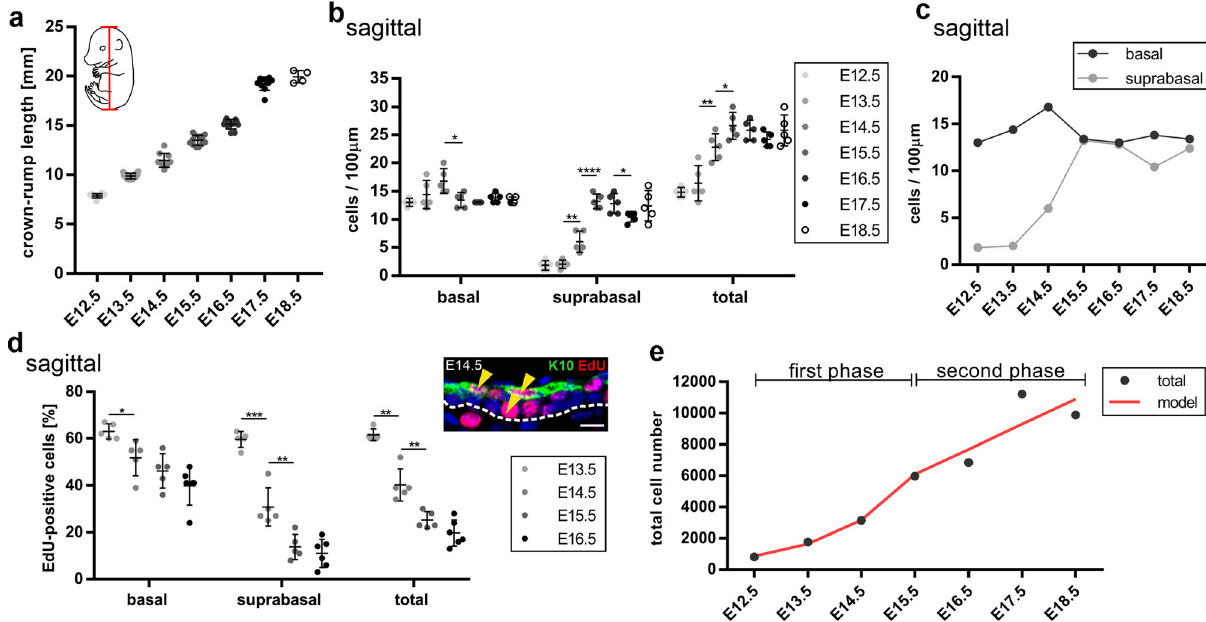
Fig. 6 Skin epidermal strati fi cation occurs in two phases. a Quanti fi cation of the crown-rump distance as depicted in the embryo schematic (red line) in wild-type embryos from E12.5 – E18.5. Note the linear trend of the growth. E12.5: n = 10, E13.5: n = 16, E14.5: n = 10, E15.5: n = 12, E16.5: n = 11, E17.5: n = 10 and E18.5: n = 4 b , c Cell densities (cells per 100 µ m) of basal and suprabasal layers of sagittal back-skin sections of the epidermis from E12.5 – E18.5 with n = 5 independent animals for each time point. c The suprabasal cell density reaches parity with that of the basal layer starting at E15.5. d Quanti fi cation of EdU-positive cells in the basal and suprabasal layers from sagittal back-skin sections of the epidermis at the indicated time points, with an example of the EdU (red)/K10 (green) staining shown at E14.5 (arrowheads) (scale bar: 10 µ m). n = 5 for E13.5 – E15.5 and n = 6 for E16.5. e The graph depicts the exponential increase in total cell number in the fi rst phase of strati fi cation between E12.5 – E15.5 and the linear-trend increase in the second phase between E15.5 – E18.5, shown as the calculated total cell number from the measurements (total) and in agreement with the model (red line). * p < 0.05, ** p < 0.01, *** p < 0.001, **** p < 0.0001 (two-tailed student ’ s T -test). Bars represent mean ±